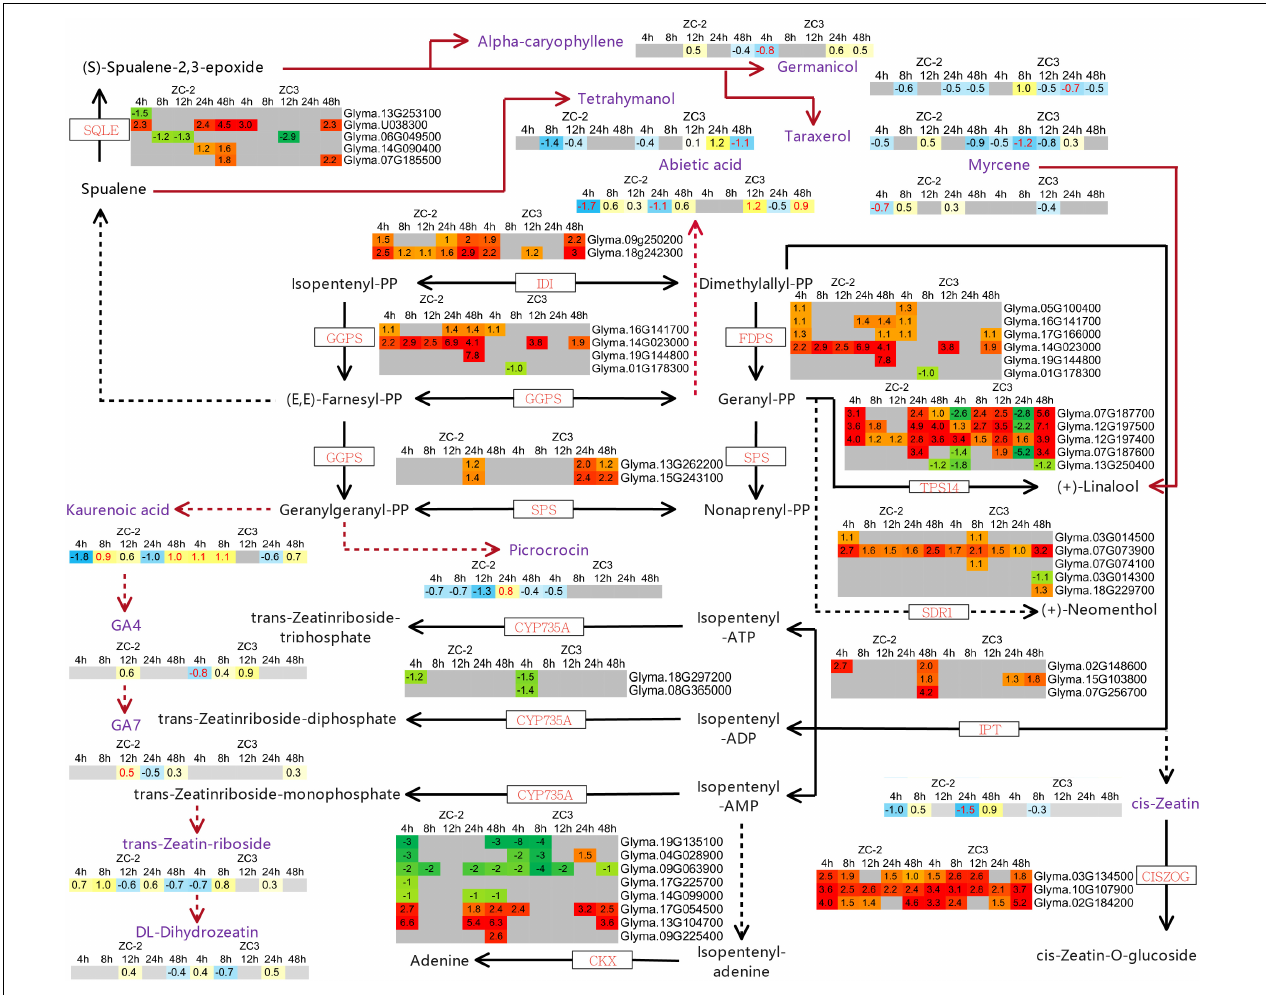
FIGURE 9 | Schematic diagram of terpenoid backbone biosynthesis and zeatin biosynthesis with heatmaps of the associated differentially expressed genes (DEGs) and differentially accumulated metabolites (DAMs). The log 2 expression fold change is color-coded in each box: red and yellow indicate up-regulated DEGs and DAMs, and green and blue indicate down-regulated DEGs and DAMs, respectively. Each row represents a DEG or DAM; the columns represent each sampling time point [4, 8, 12, 24, and 48 h post-inoculation (HPI)] for ZC-2 and ZC3. Abbreviations for DEGs are in red font and those for DAMs are in purple